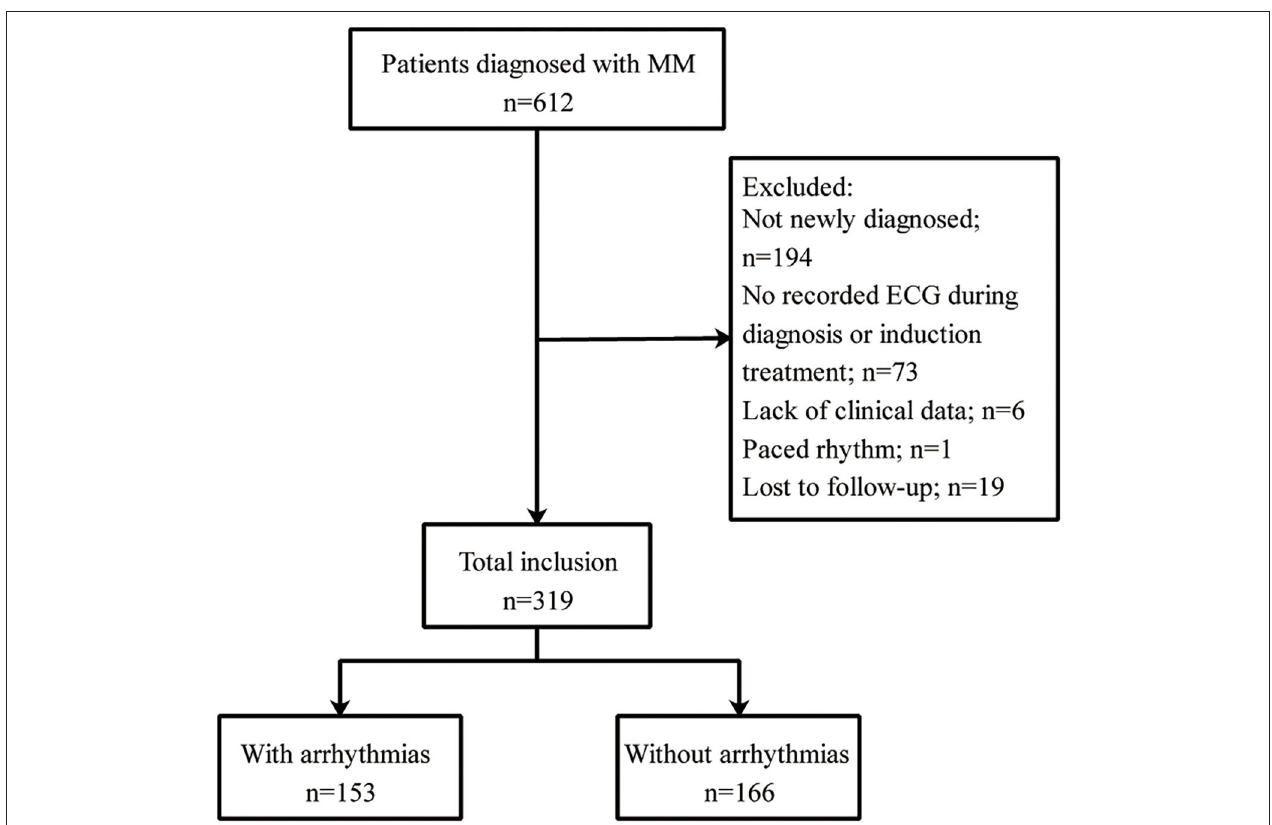
FIGURE 1 | Patient selection flowchart. MM, multiple myeloma; ECG,